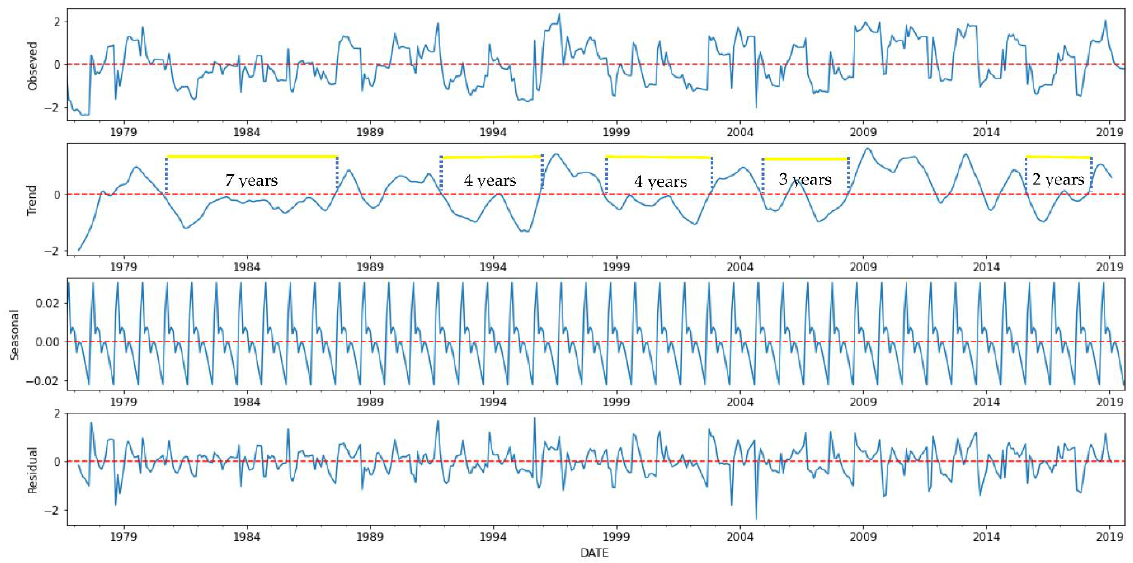
Figure 5. Seasonal decompositions applied on the standard Precipitation Evapotranspiration Index (SPEI) at Aguibat Ezziar station.